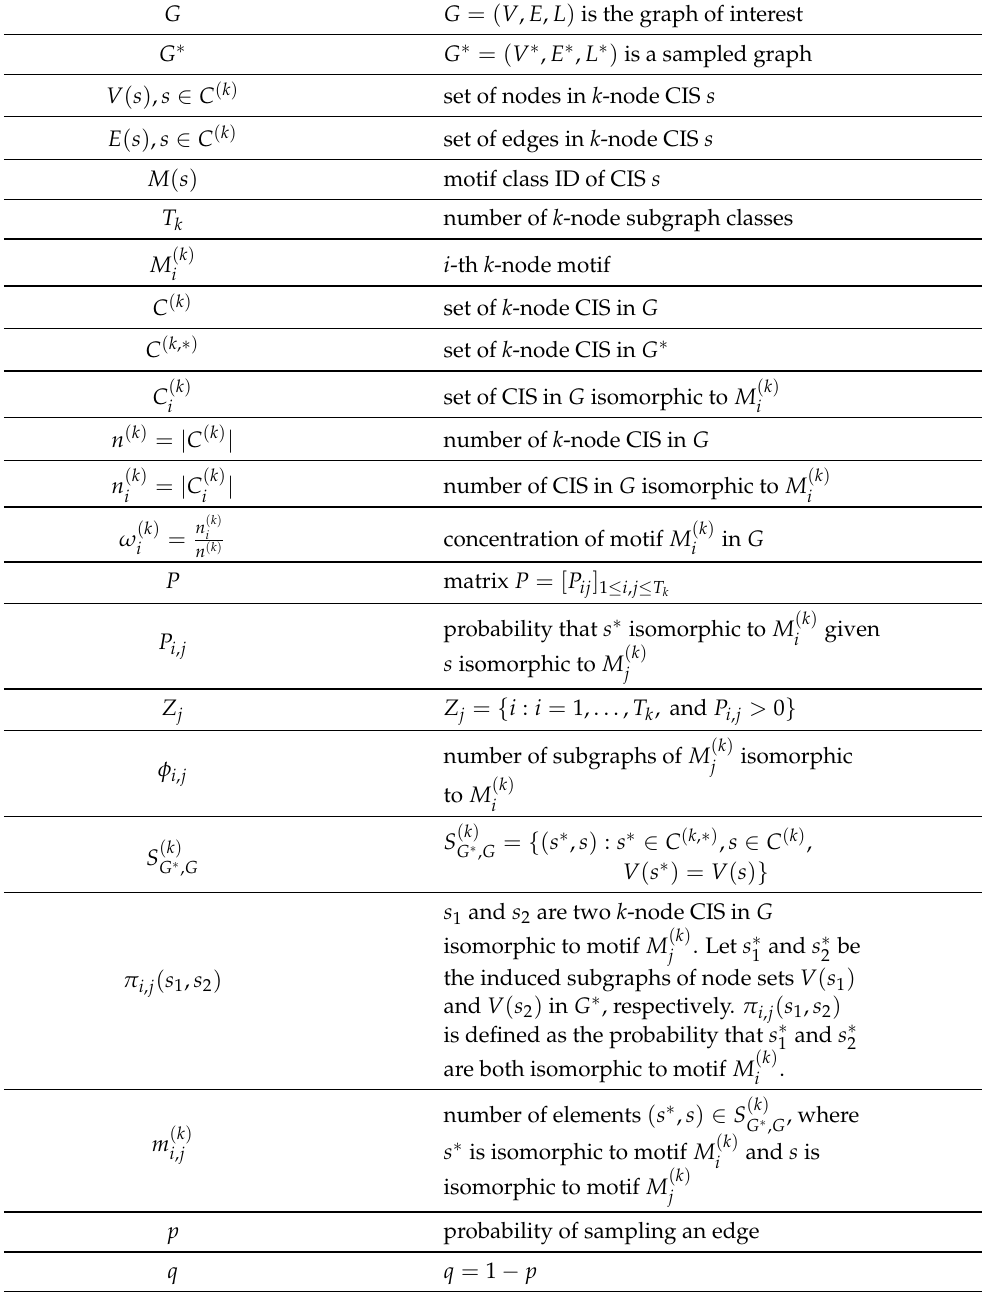
Table 1. Table of